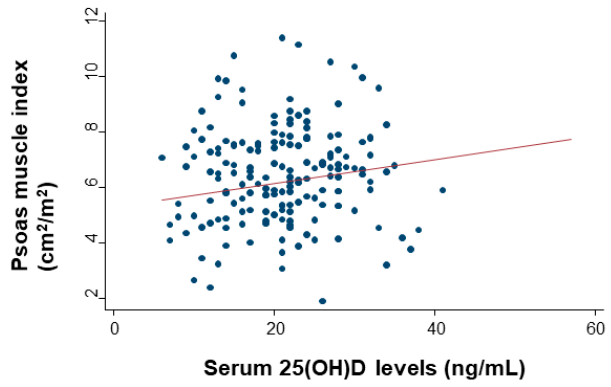
Figure 3. Collinearity levels of serum serum 25-hydroxyvitamin D (25(OH)D) levels and the psoas muscle index (PMI). Spearman’s rank correlation with linear regression was used to quantify the strength of the association.